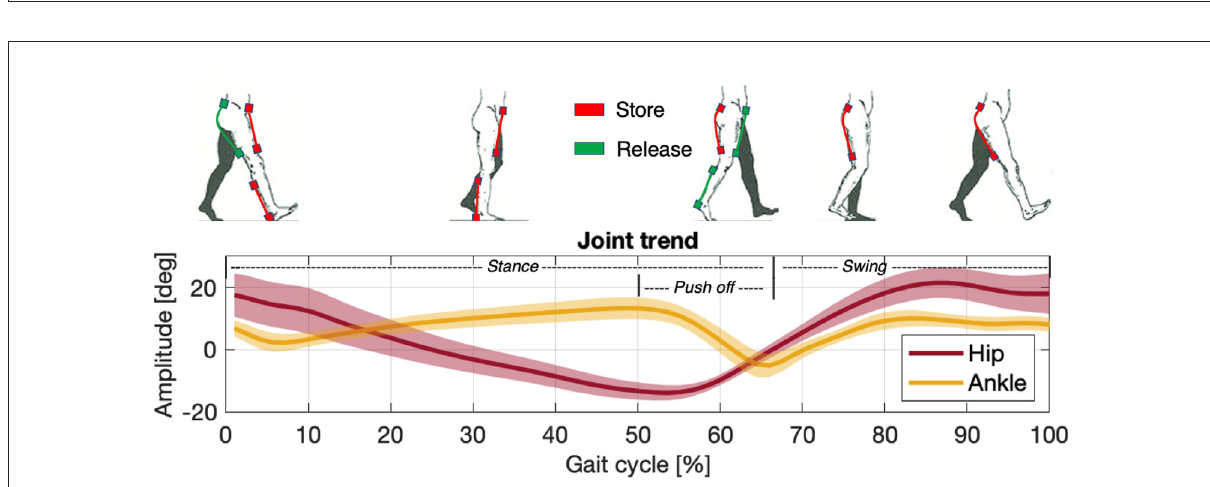
FIGURE2 Storage (red) and release (green) phases of the actuation unit compared against the joint/limb rotation patterns of the hip (dark red) and ankle (yellow) in a gait cycle.